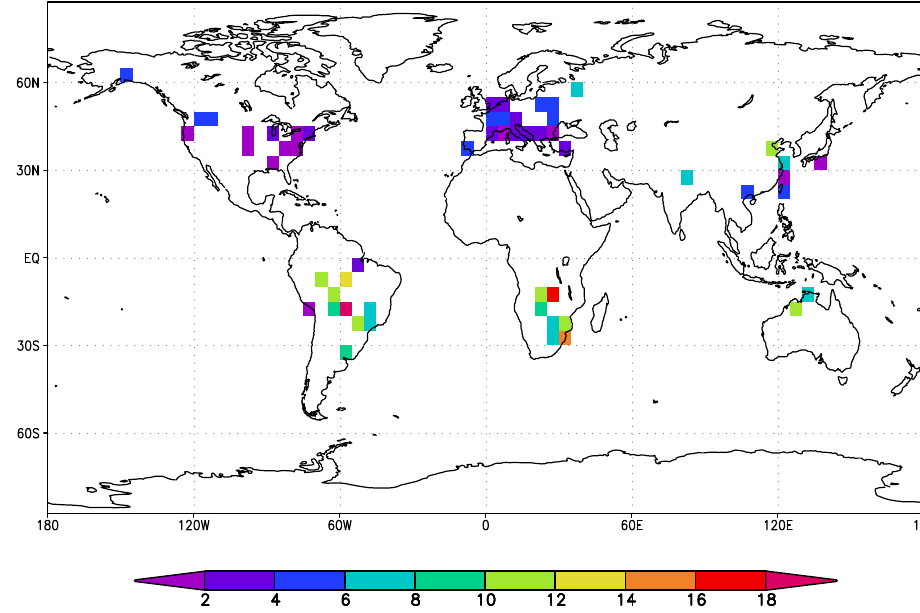
Fig. 2. Mean absorbing OC concentration (mgm − 2 ) inferred from AERONET-retrieved imaginary indices for September.